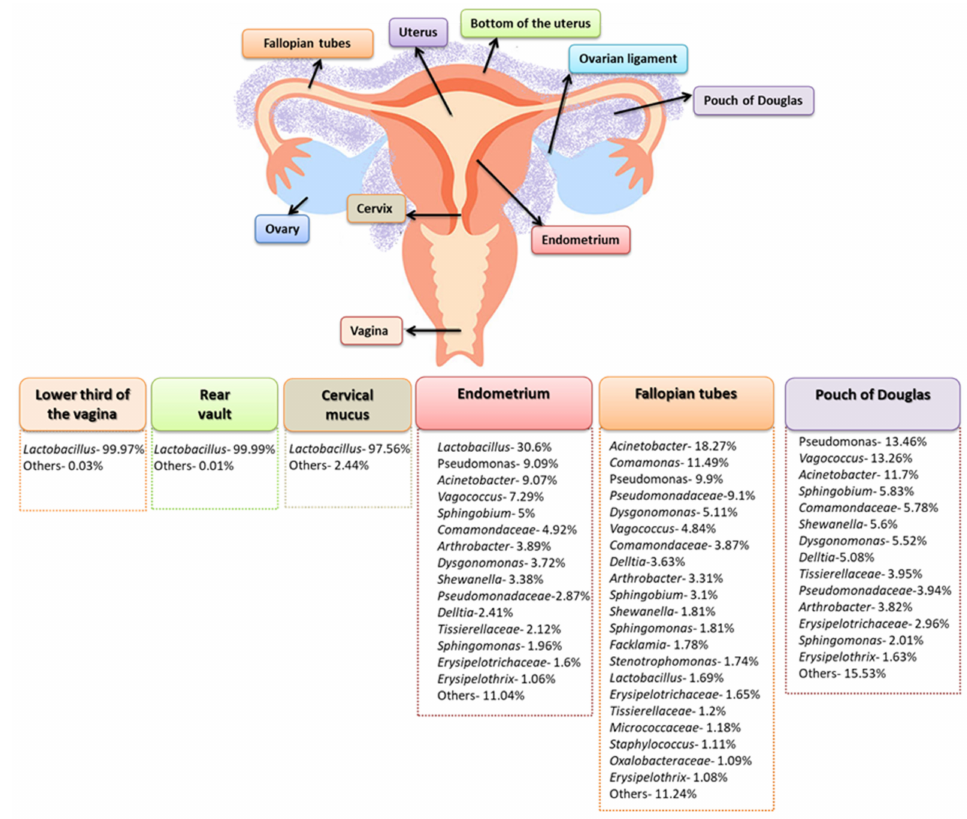
Figure 3. Differentiation in the composition of the female genital tract’s microbiota (based on